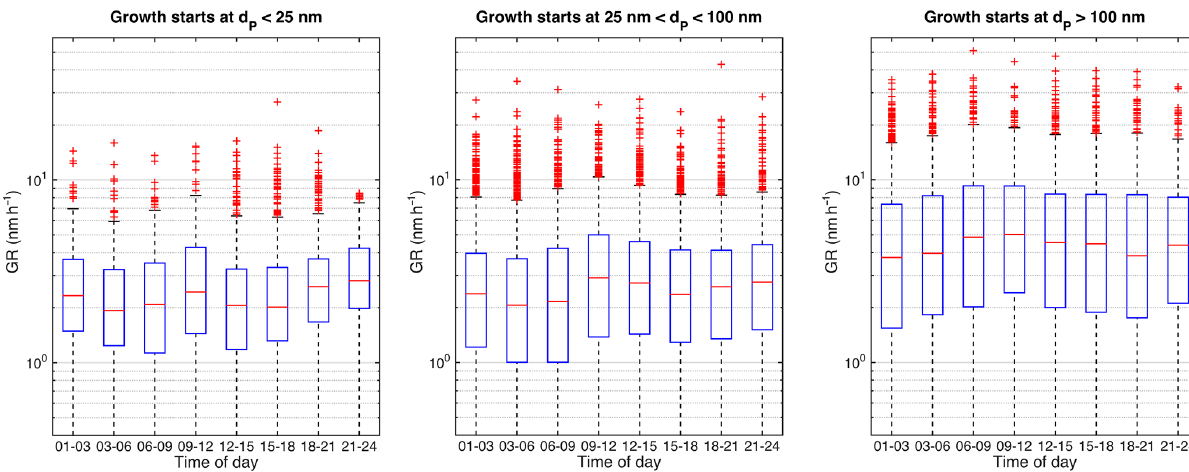
Figure 2. Diurnal variation of all the determined growth rates in different size ranges. Red horizontal line represents the median value and the blue box the 25th and 75th percentile values. The whiskers reach approximately ± 2 . 7 σ and the red markers are outliers from this range.